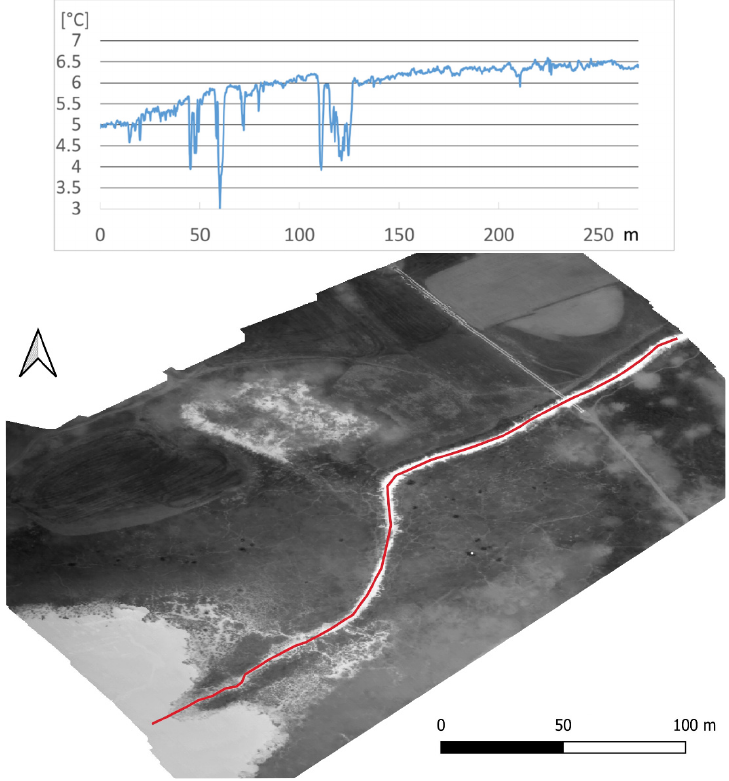
Figure 7. Temperature changes at the mouth of Cybina to Lake Swarz ę dzkie. The red line represents the path in which the temperature measurements were taken, shown in the graph with the blue line.